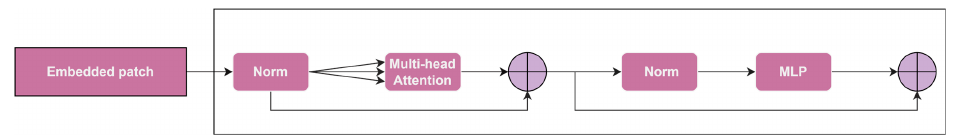
Figure 7. Transformer Encoder.